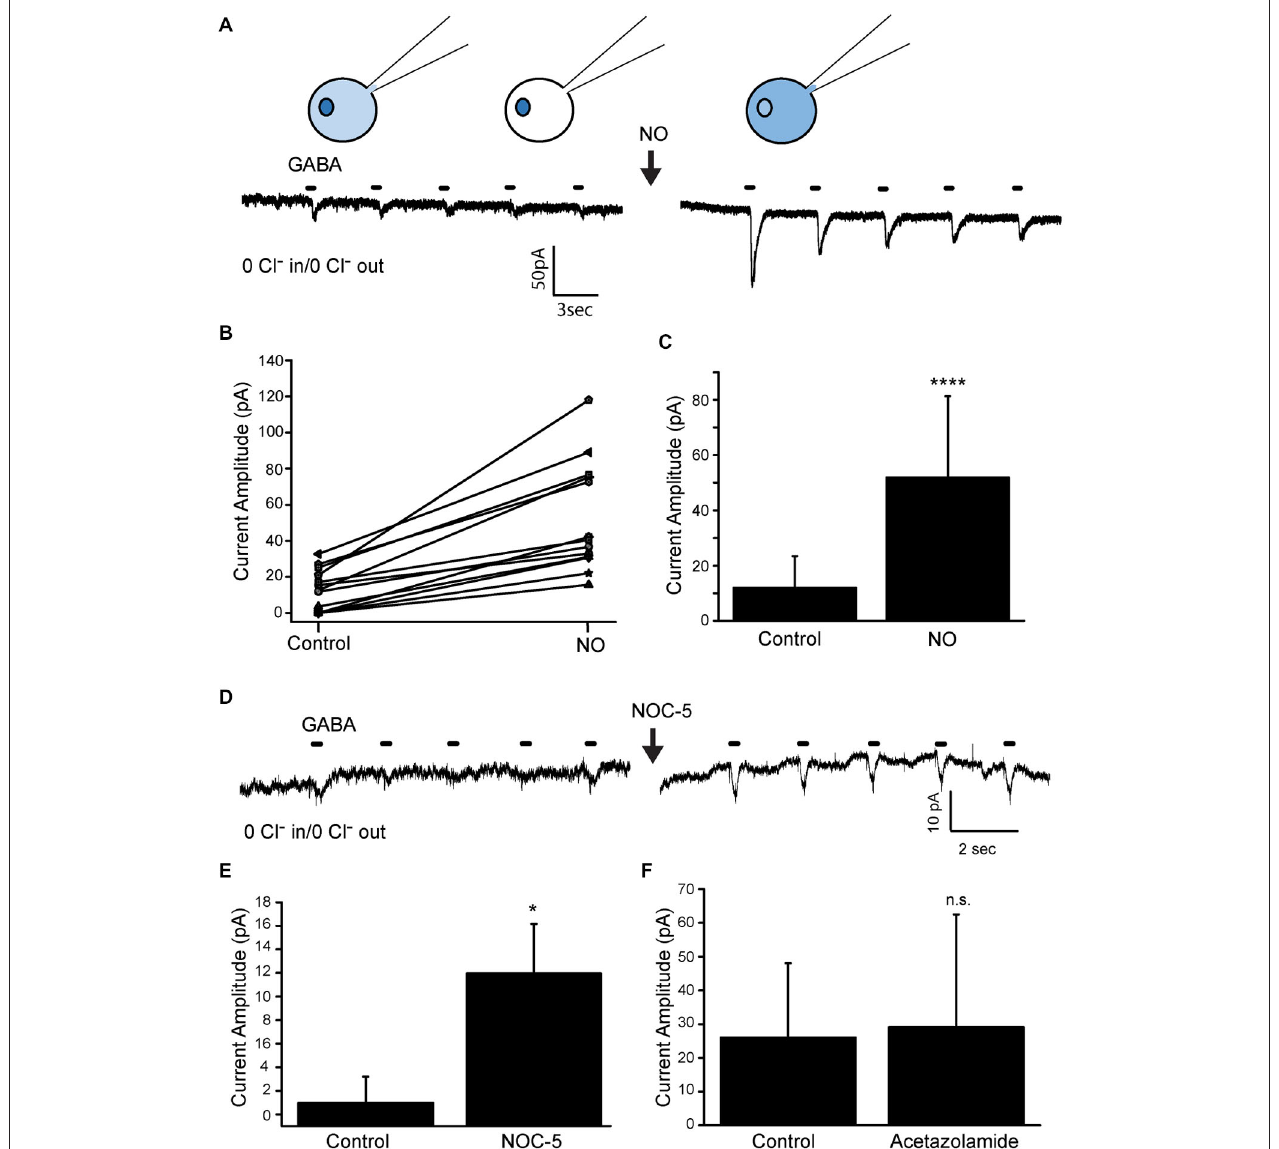
recorded. Data were collected from the response to the first GABA pulse and from the response to the 6th GABA pulse delivered just after NO. (C) , Mean current amplitude of the data shown in (B) . (D,E) , Data from an experiment like the one shown in (A) but here the NO donor NOC-5 (500 µ M) is used rather than the NO-bubbled solution. The NO donor also causes a significant increase in the amplitude in the NO-dependent GABA-gated currents. (F) , Mean NO-dependent current amplitude of GABA-gated currents recorded before and after the addition of acetazolamide (400 µ m). **** denotes p <